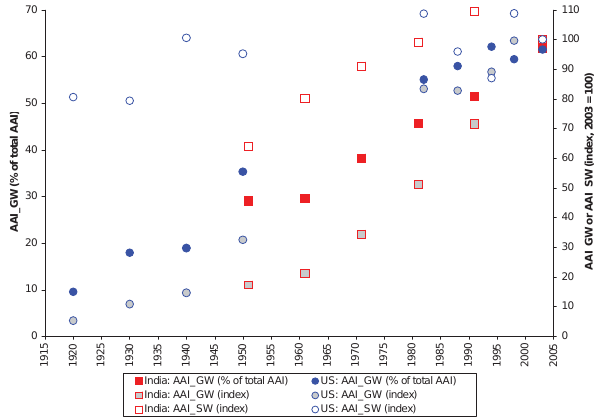
Fig. 4. Historical development of area actually irrigated with groundwater (AAI GW) as percentage of total actually irrigated area, AAI GW as index (2003=100), area actually irrigated with surface water (AAI SW) as index (2003=100) for India and the USA (sources: agricultural census data reported in INDIAAGRISTAT (2010) and Narayanamoorthy (2006) for India and US Department of Commerce (1922, 1932, 1942, 1952, 1984), US Department of Agriculture (1996), Glickman et al. (1999) and Veneman et al. (2004) for the